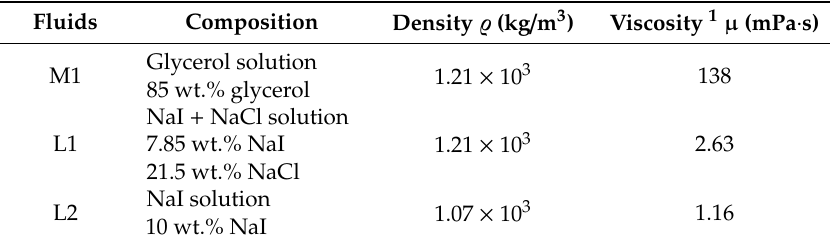
Table 1. Properties of the fluids used in the